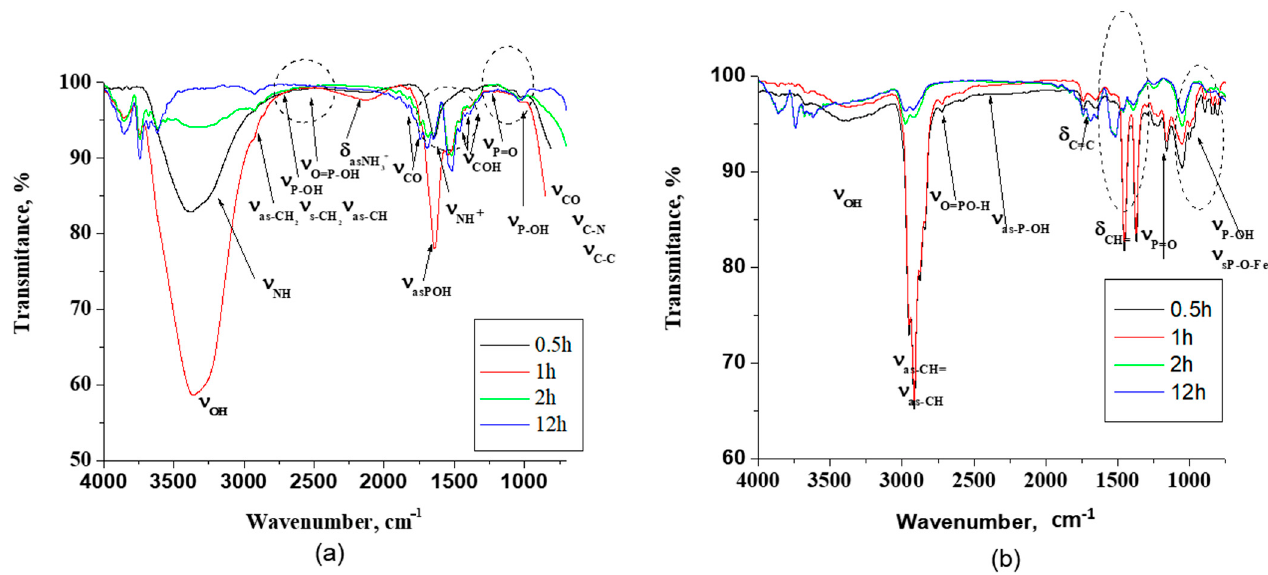
Figure 2. ATR-FTIR spectra for ( a ) N , N ′ -phosphonomethylglycine (PMG) and ( b ) for vinyl phos- phonic acid (VPA).